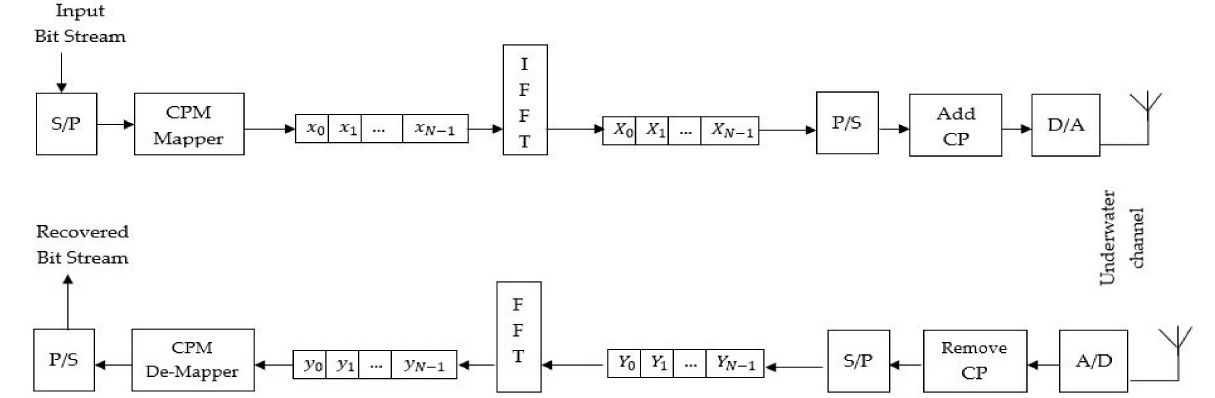
Figure 13. Transceiver block diagram of CPM-OFDM for UWAC